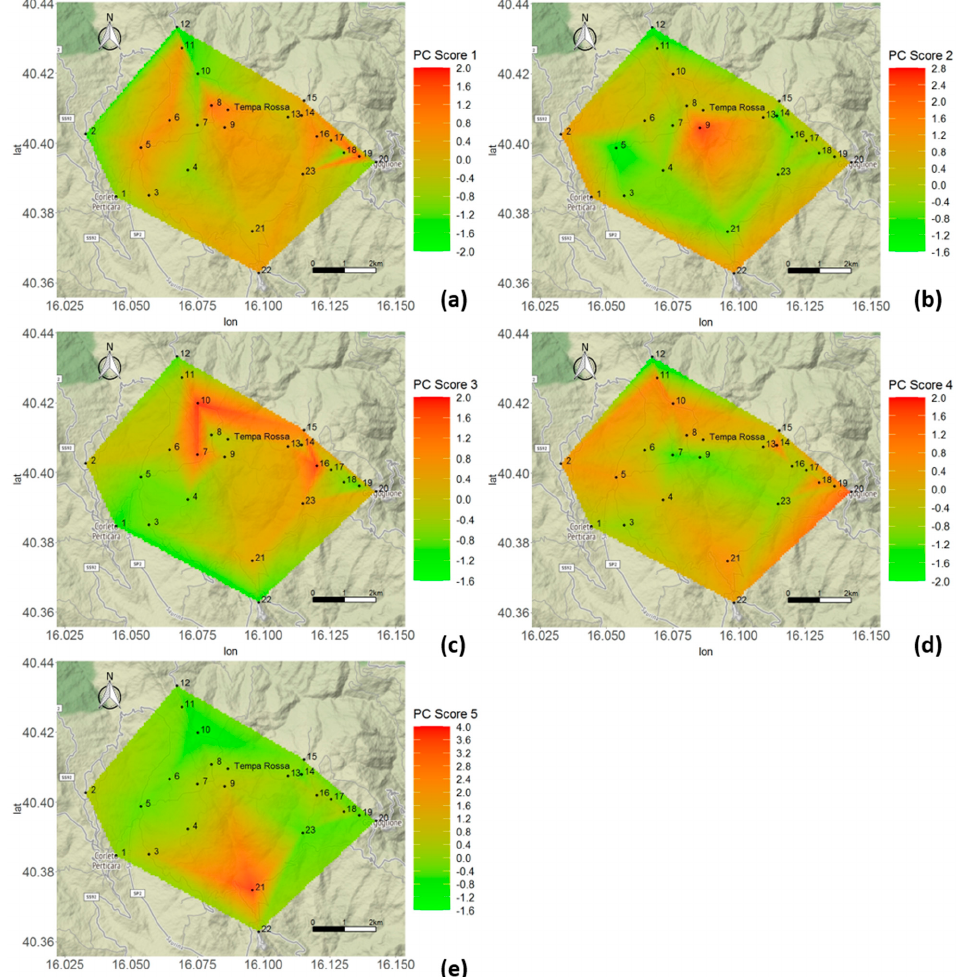
Figure 4. Maps of the PC_score plot with respect to the observations of the five components extracted ( a – e ). The numbers 1–23 represent the sampling points.